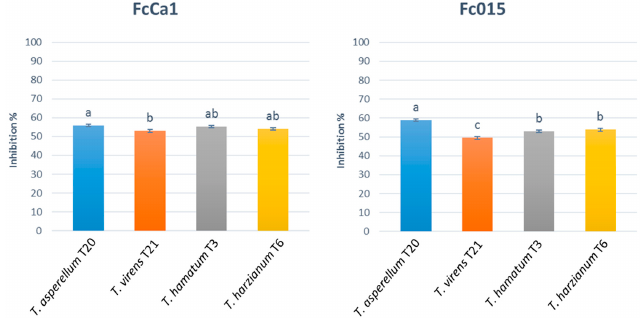
Figure 1. Percent inhibition of F. circinatum (FcCa1 and Fc015) mycelial growth in the dual test with Trichoderma spp. Different letters indicate significant differences at p < 0.05, according to Tukey’s post-hoc test. Vertical bars indicate standard error (SE).